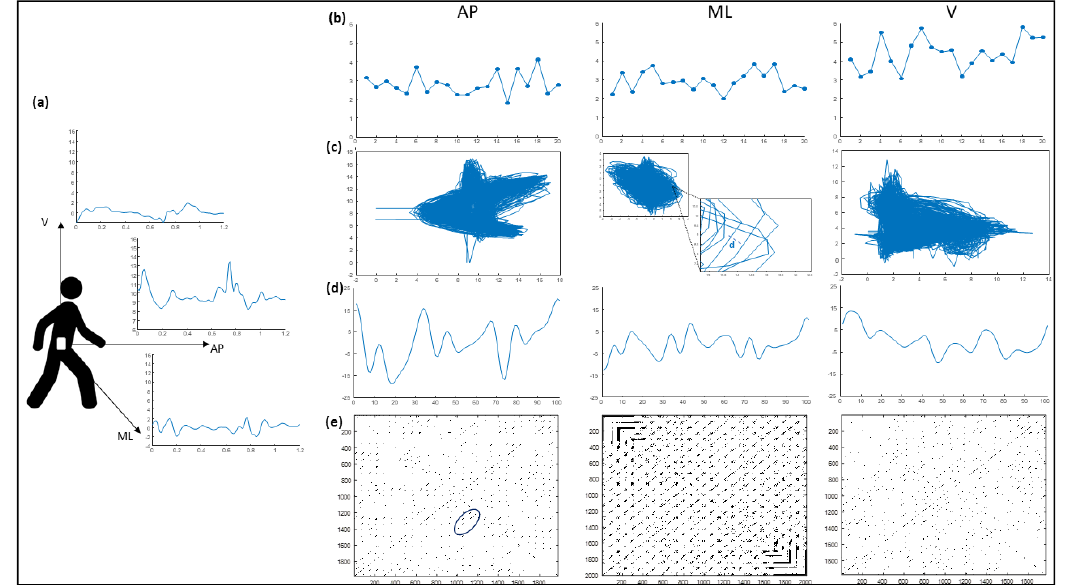
Figure 1. Graphical representation of the accelerations-derived gait indexes of a representative healthy subject: ( a ) ampli- tudes of the filtered acceleration signals in the antero-posterior (AP), medio-lateral (ML), and vertical (V) direction as a function of the time range data; ( b ) Harmonic Ratio values for each of the 20 considered strides; ( c ) 2D-reconstructed state space of the acceleration and its time-delayed copies (time delay of 12 data samples). The distance ( d ) of two neighboring trajectories at a one-time sample, which is needed to calculate the Lyapunov exponent, is highlighted; ( d ) representation of the jerks during the whole gait cycle; ( e ) recurrence matrix. Based on the percent of the recurrent points in the diagonal line structure parallel to the main diagonal (i.e., the blue circled points), the RQAdet was calculated.